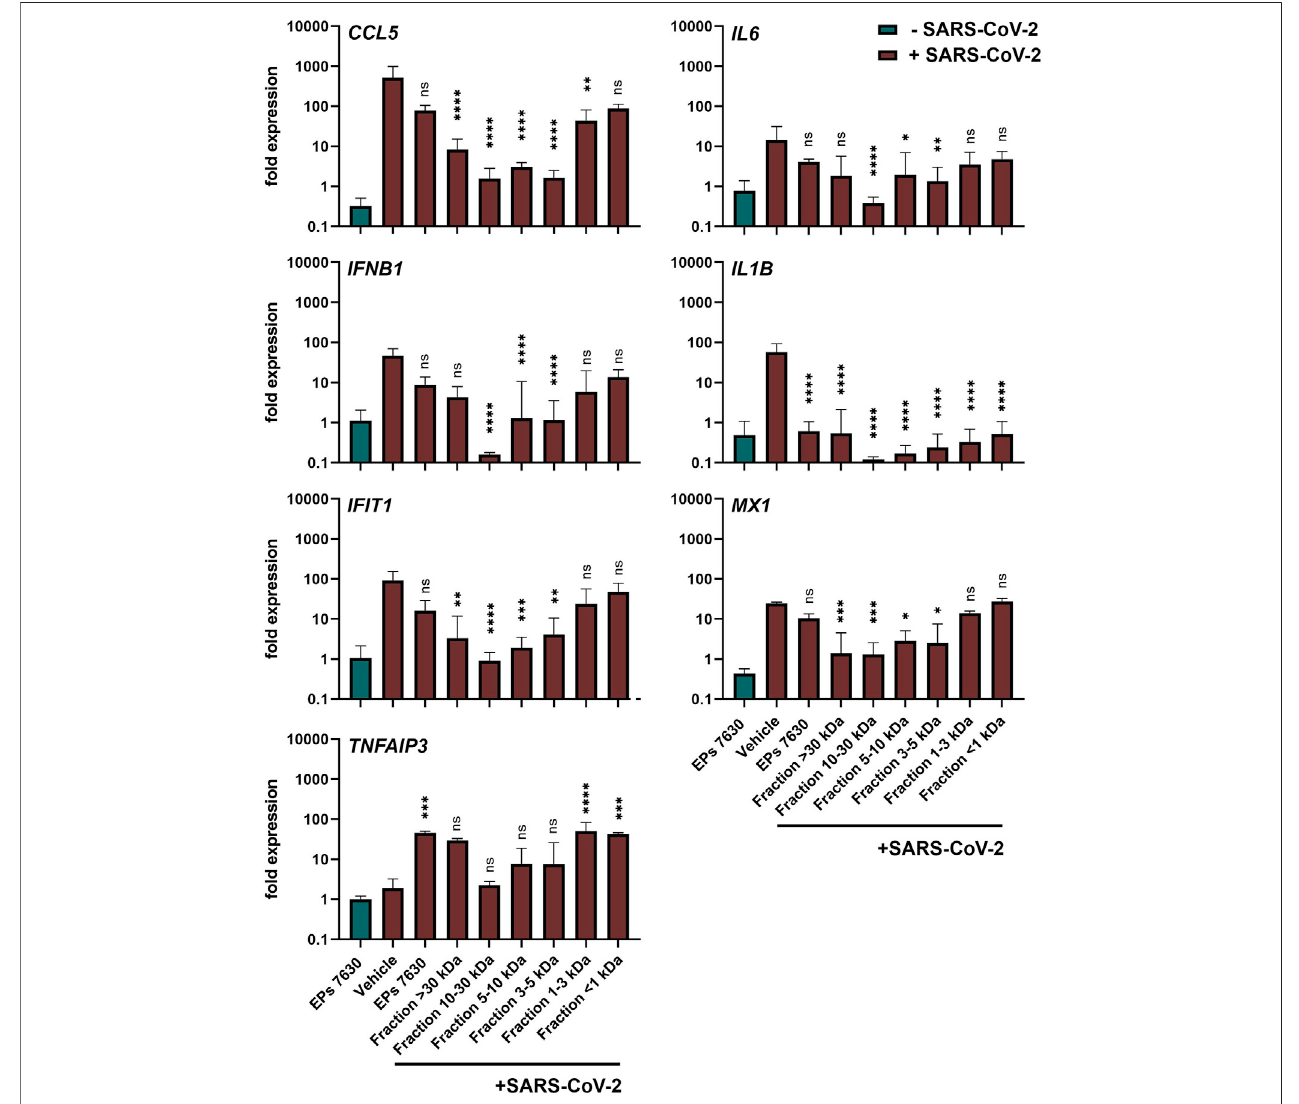
FIGURE 5 | Calu-3 cells treated with EPs 7630 or ultra fi ltrated fractions show enhanced anti-in fl ammatory responses during SARS-CoV-2 infection. Calu-3 cells were treated with EPs 7630 (100 μ g/ml), infected with SARS-CoV-2 (MOI (cid:2) 0.0005; vehicle), or a combination of both. Additionally, cells were treated with ultra fi ltrated fractions of EPs 7630 and infected with SARSCoV-2. Cell lysates were prepared 48 h post-infection and cellular RNA of the indicated immune genes was quanti fi ed by RT-qPCR. Green bars show EPs 7630-treated, non-infected cells for comparison. Vehicle (cid:2) medium. Data are derived from n (cid:2) 3 biological samples and are presented as fold gene expression relative to untreated cells and normalized to reference gene expression ( TBP ). Statistical signi fi cance in samples from SARS-CoV-2 infected cells (treatment vs. vehicle) isindicated by (*) asdetermined by two-way ANOVA with Dunnett ’ s multiple comparison testing. (*) (cid:2) p < 0.05; (**) (cid:2) p < 0.01; (***) (cid:2) p < 0.001; (****) (cid:2) p < 0.0001.